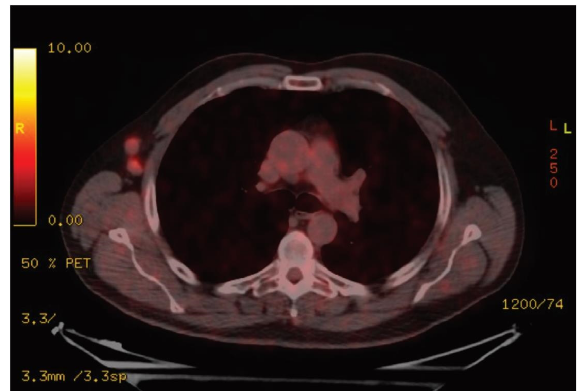
Figure 3: PET-CTscan 6 months after frst diagnosis showing two metastasic lymph nodes in the right